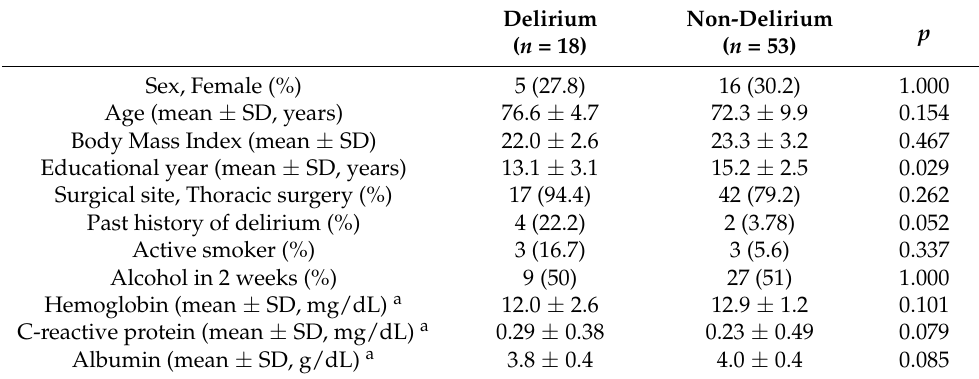
Figure 2. Recruitment flow chart. Eighty patients were recruited, and 73 patients were tested in the preoperative period. The emergence of delirium was assessed during postoperative days 2–5. Finally, 18 patients were classified into the delirium group, and 53 patients into the non-delirium group. Table 1. Clinico-demographic data.